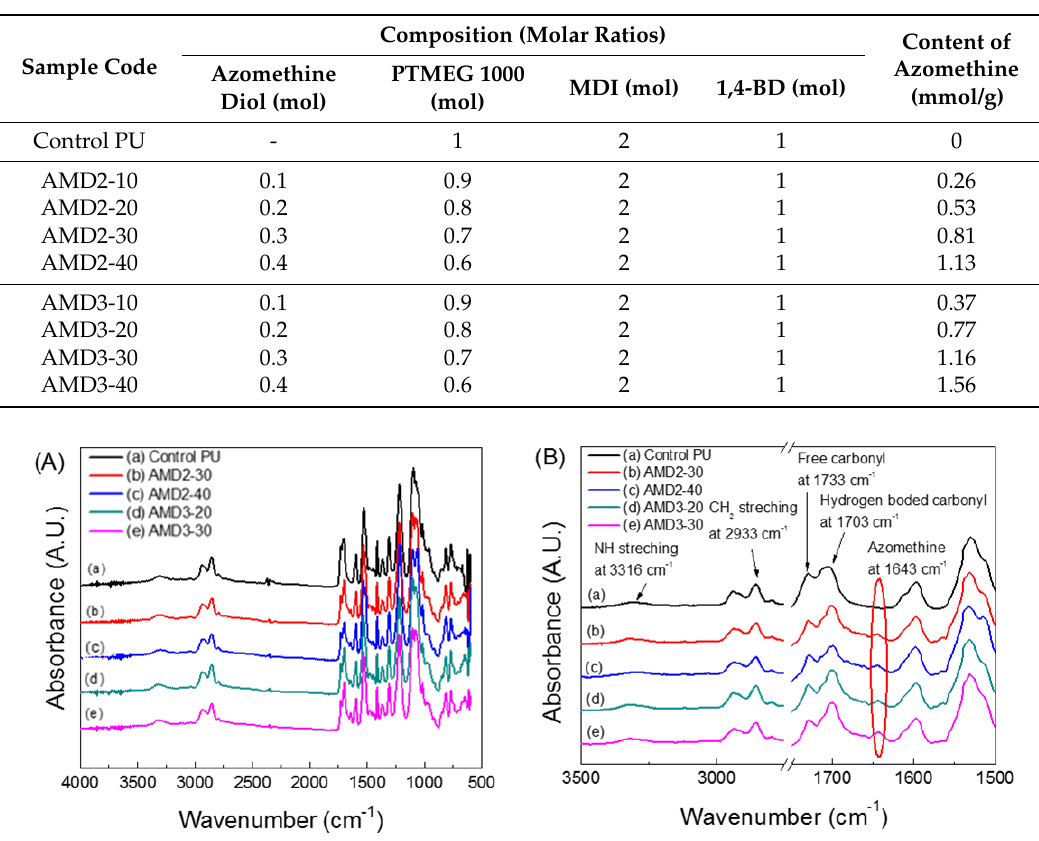
Table 1. Sample code and composition of synthesized PUEs.